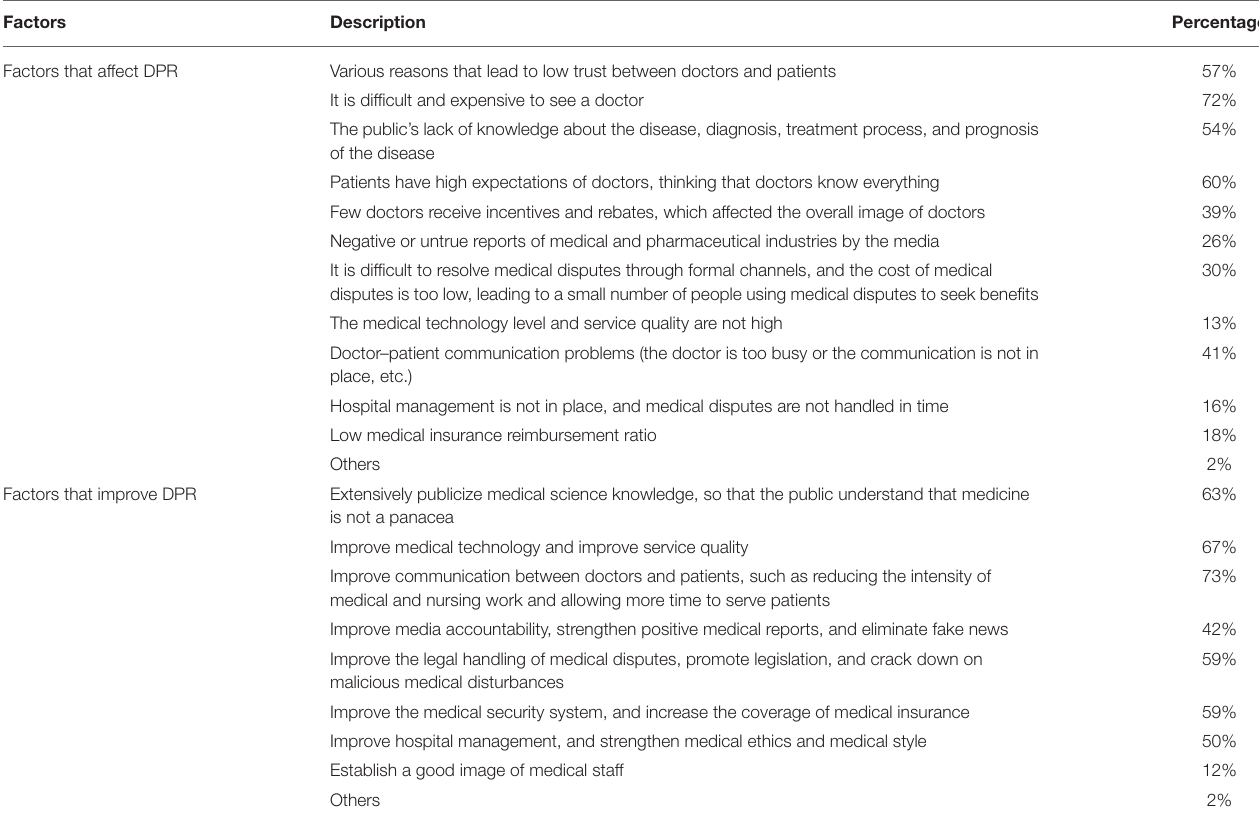
TABLE 2 | Factors that affect and improve doctor–patient relationship.